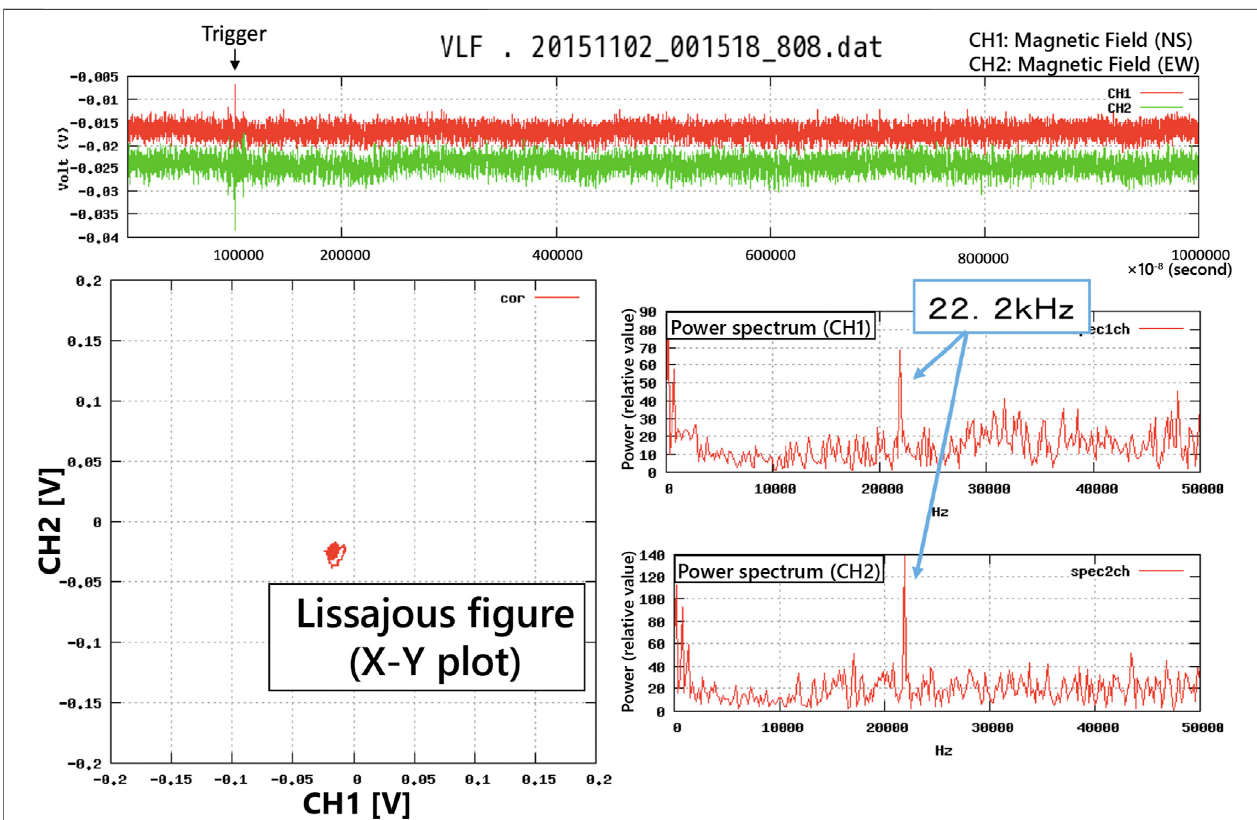
FIGURE 2 | Output image of the observed electromagnetic waveforms and power spectrums (Top) Observed waveforms. CH1 (red line) shows the north-south (NS) component of the observed magnetic fi eld, and CH2 (green line) shows the east-west (EW) component. Waveforms were recorded 1 ms before and 9 ms after triggering during this test period (Lower left) ALissajous fi gure (X – Y plot) ofthe observed electromagnetic wave (Lower right) Power spectrums of CH1 and CH2. Apeak at 22.2 kHz was caused by the electromagnetic waves transmitted from Ebino, as shown in Figure 1 .